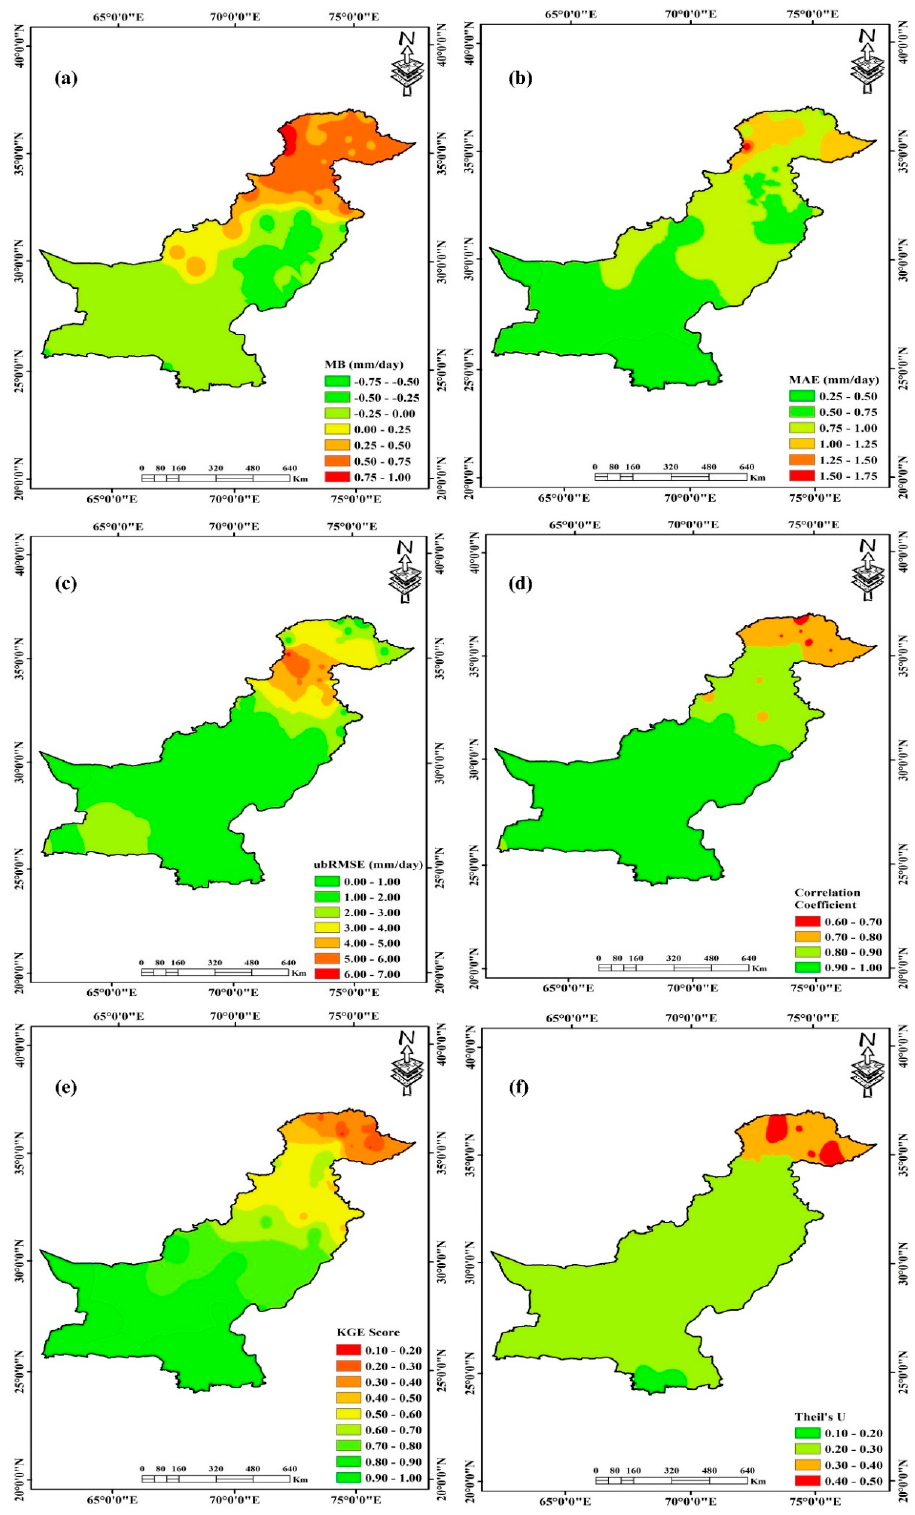
Figure 10. Performance assessment of WALS-RBPD using six statistical indices. ( a ) Mean bias (MB); ( b ) Mean absolute error (MAE); ( c ) Unbiased root mean square error (ubRMSE); ( d ) Correlation coefficient ( R) ; ( e ) Kling–Gupta efficiency (KGE) score; ( f ) Theil’s U.